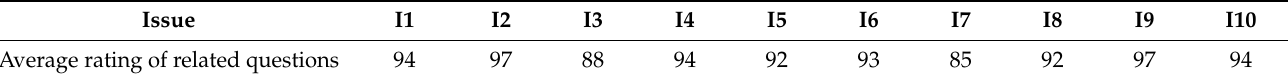
Table 8. Average rating of issues and related